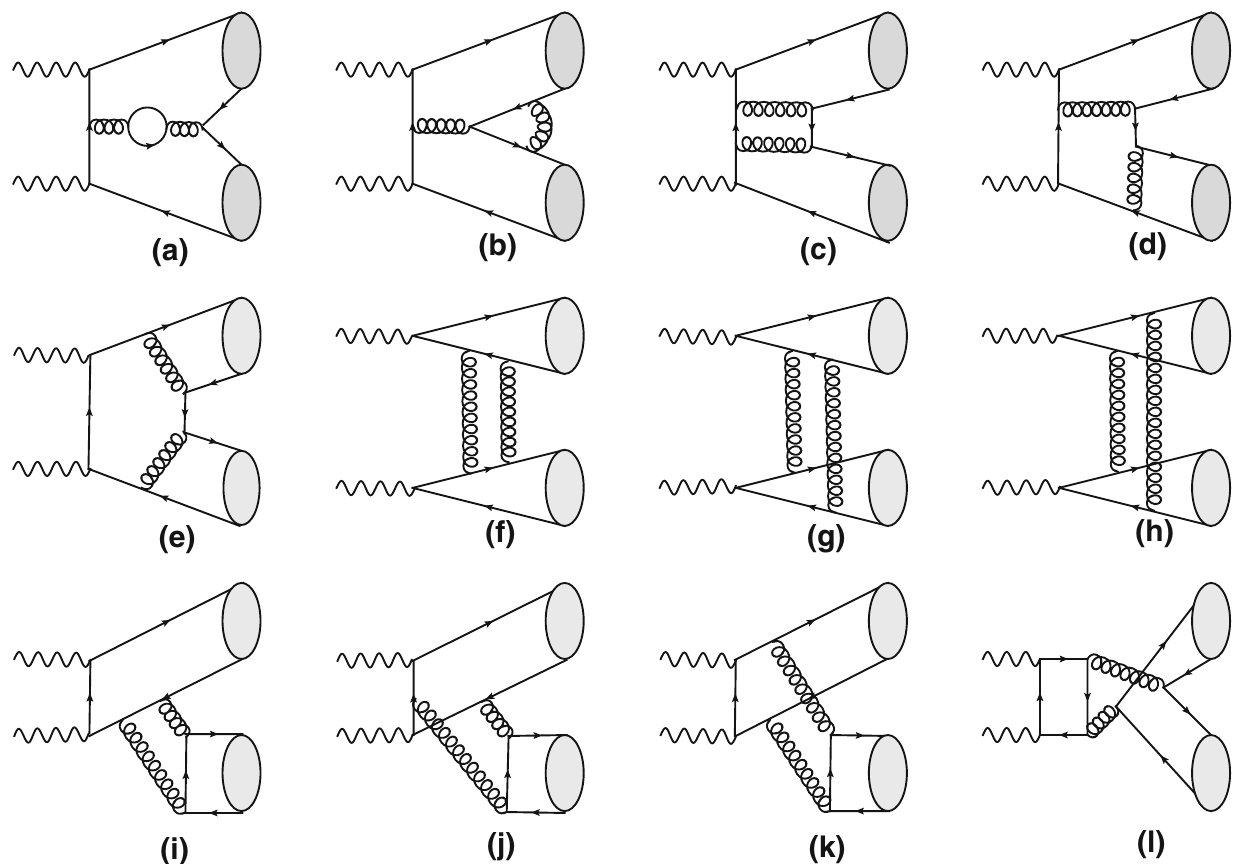
Fig. 2 Typical NLO Feynman diagrams for quarkonium-pair production via photon–photon